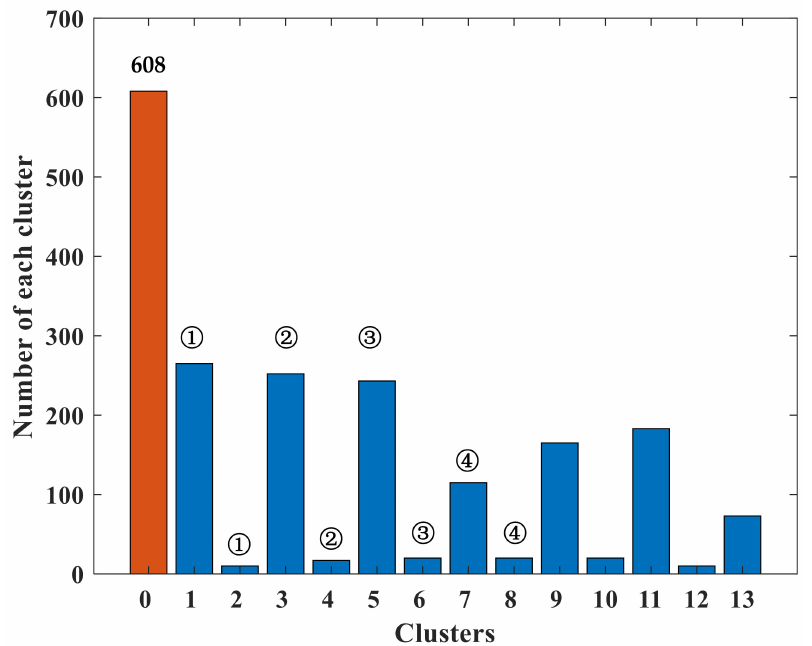
Figure 12. The number of the sheath current samples in each cluster of the MV cable circuit ( 1 (cid:13) ~ 4 (cid:13) represent the traveling wave steps no.1 to